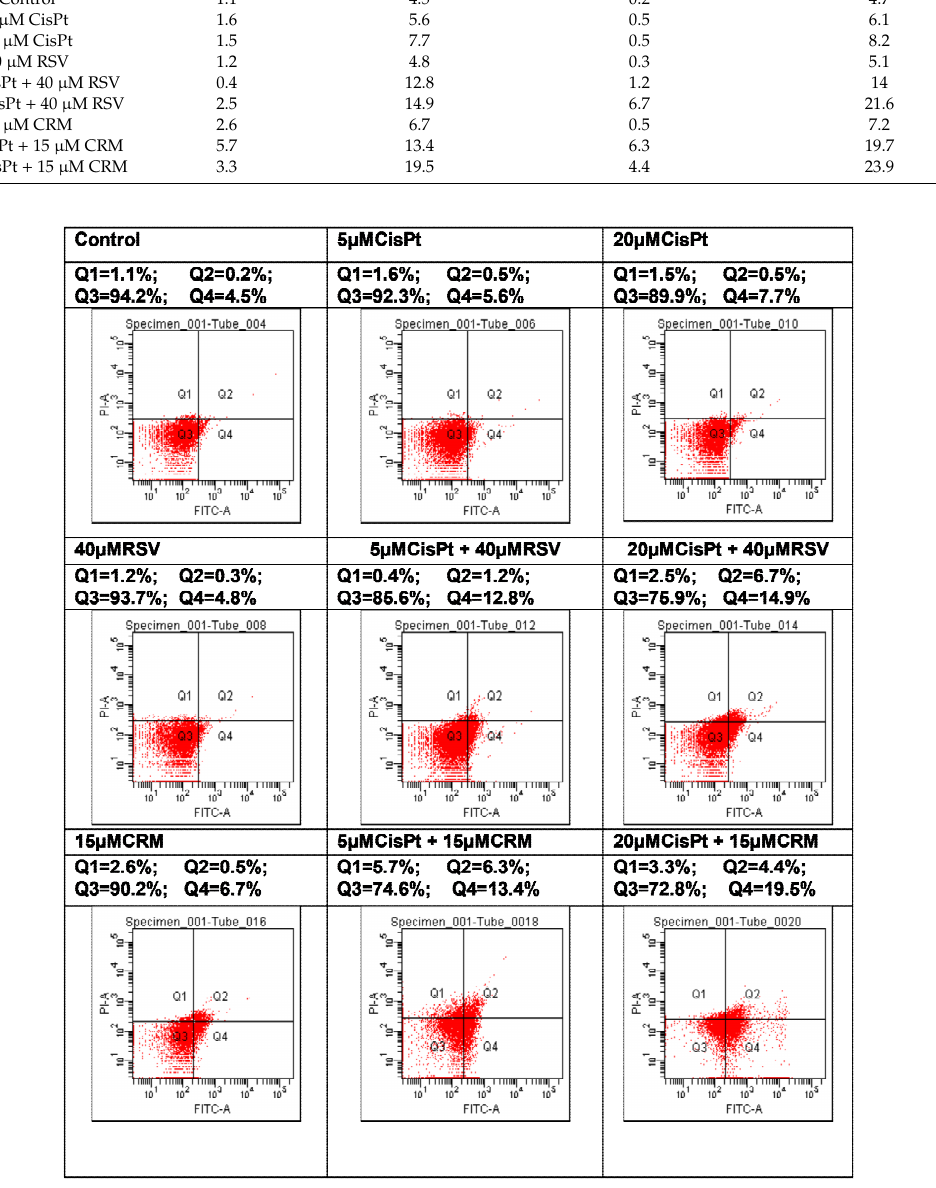
Figure 8. Natural compounds (RSV or CRM) effects on the apoptotic process on normal HUVEC cells treated 24 h with CisPt (Dot-plot analysis.). Table 7. Apoptosis of HUVEC cells induced by 24 h treatment with CisPt and/or RSV, CRM.